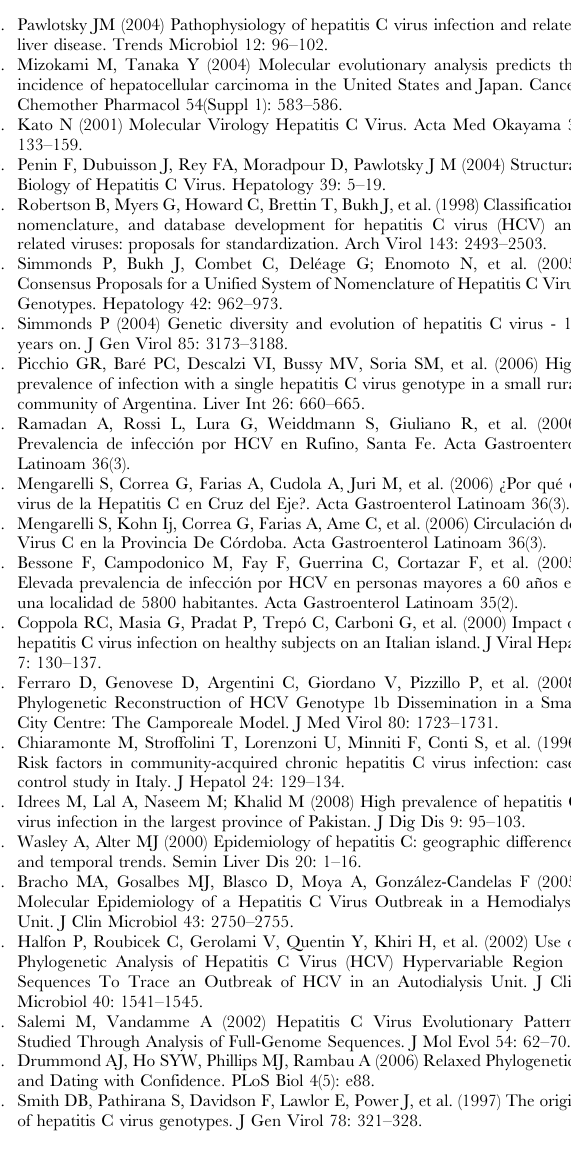
Figure S4 The marginal posterior density for the tMRCA for independent MCMC runs under different models. A) E1/E2 gene with HVR1. B) E1/E2 gene without HVR1 and C) NS5B